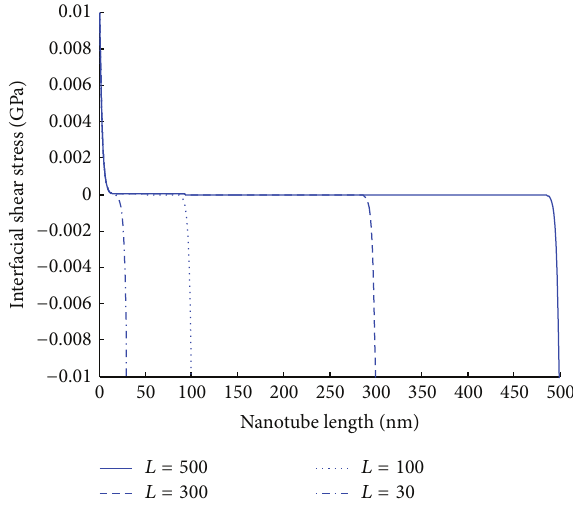
Figure9:ShearstressattheSWNT/aluminainterfacealongthetube length provided by van der Waals force ( 𝑑 = 3 nm, 𝑡 = 0.34